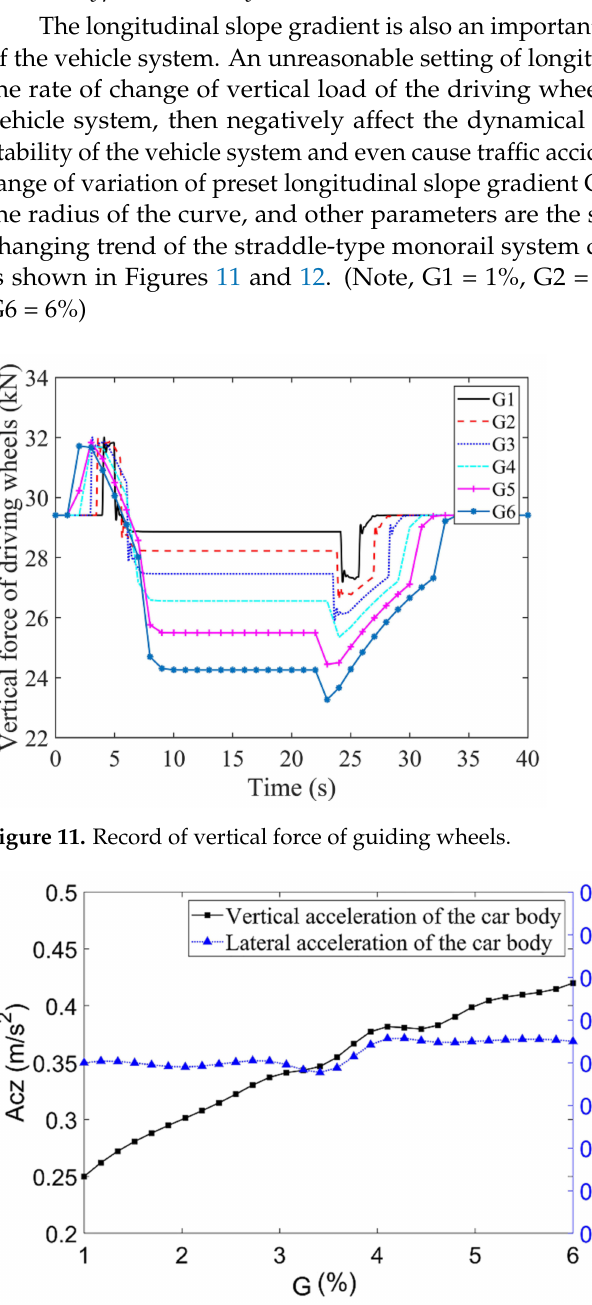
Figure 12. Maximum of vehicle body